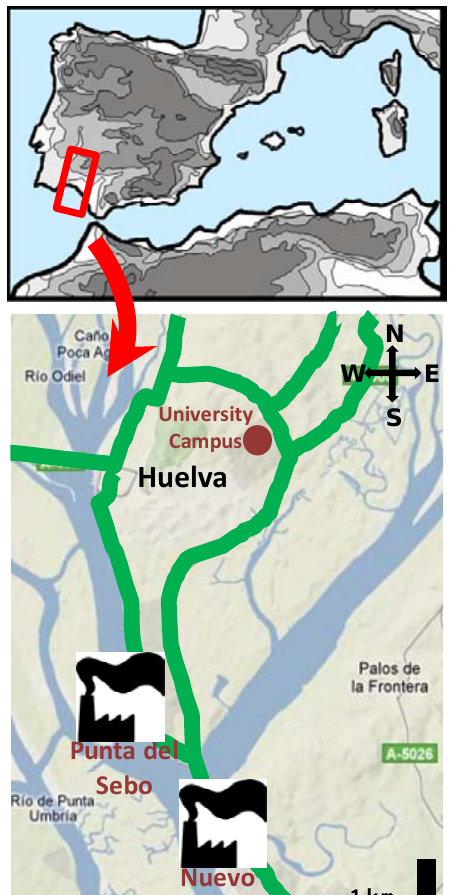
Fig. 1. Map of Huelva and the surroundings. Green lines indicate main roads and motorways around Huelva city. The two industrial areas (Punta del Sebo and Nuevo Puerto) of Huelva are